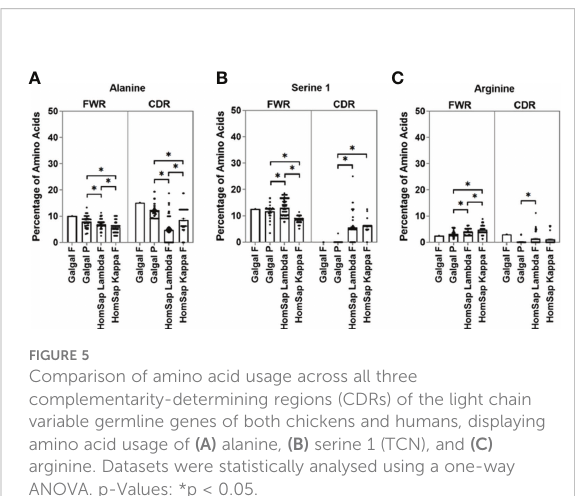
FIGURE 5 Comparison of amino acid usage across all three complementarity-determining regions (CDRs) of the light chain variable germline genes of both chickens and humans, displaying amino acid usage of (A) alanine, (B) serine 1 (TCN), and (C) arginine. Datasets were statistically analysed using a one-way ANOVA. p-Values: *p ≤ 0.05.